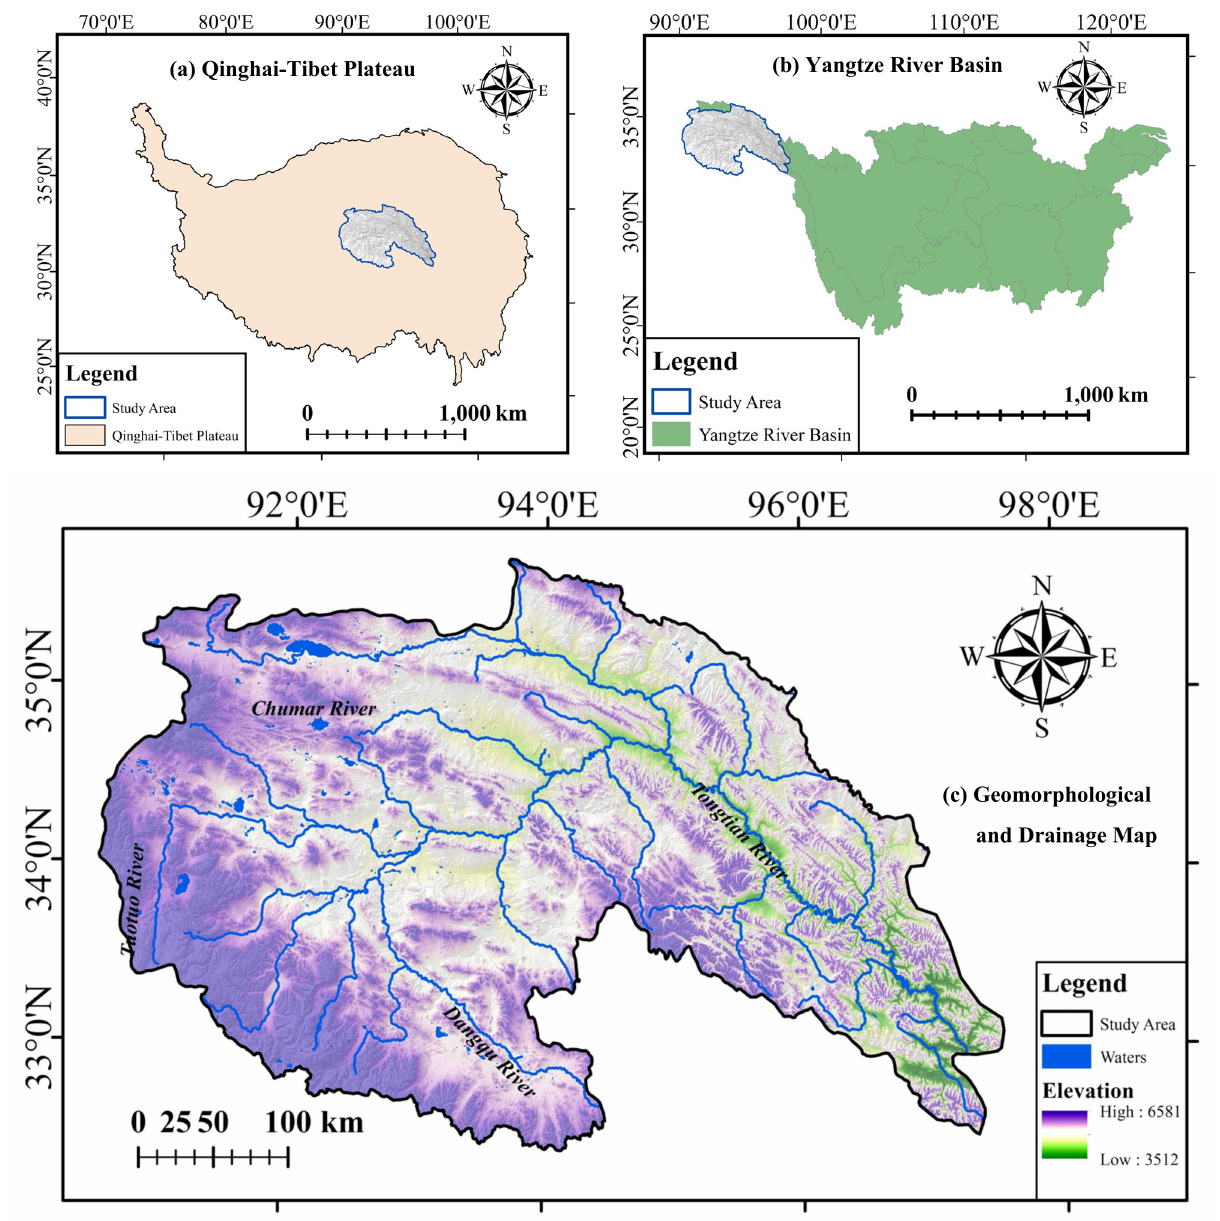
Figure 1. The location on the headwaters of the Yangtze River. ( a ) The location of the study area on the Qinghai-Tibet Plateau; ( b ) the location of the study area in the Yangtze River Basin; ( c ) the geomorphological and drainage map of the headwaters of the Yangtze